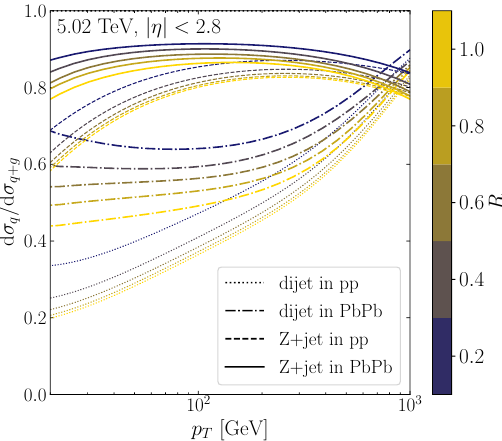
Figure 8 . The quark and gluon ratio before and after quenching for dijets and Z+jets in pp and